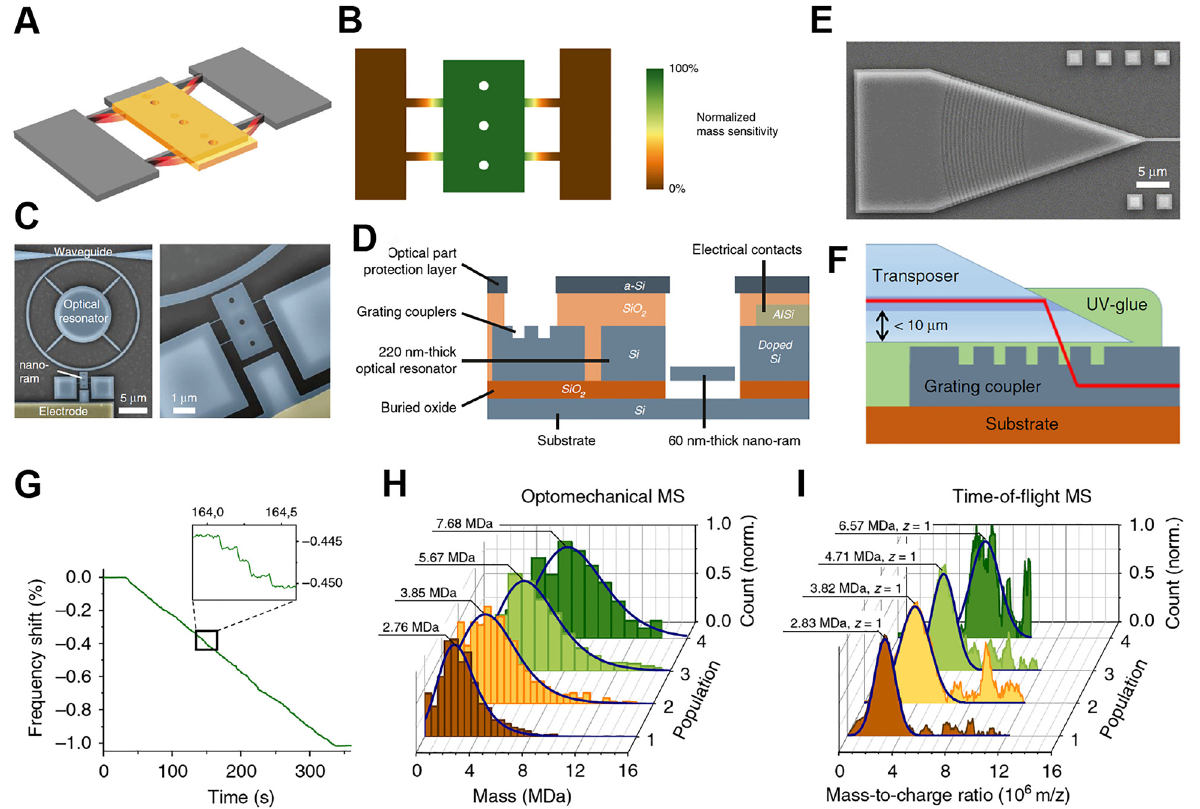
Figure 11: Single-mode optomechanical resonator for mass spectrometry [34]. (A) Mode profile of the planner mechanical resonator. (B) Mass sensitivity for different particle landing positions on the planer mechanical resonator. (C) SEM pictures of the mass spectrometer using nanomechanical resonator coupled with a microring cavity. (D) Cross section of different components of the device. (E) SEM picture of the grating structure to couple light into the microresoantor. (F) In-plane optical packaging by waveguide-to-fiber-transposer chips aligned and glued to the grating couplers. (G)–(I) Single-particle optomechanical mass spectrometry of tantalum clusters. (G) Frequency trace of the mechanical resonator for the 5.7 MDa cluster deposition. (H) Statistical distributions of different sized tantalum clusters using the optomechanical mass spectrometer. (I) Time of flight mass spectrometry for the four different tantalum